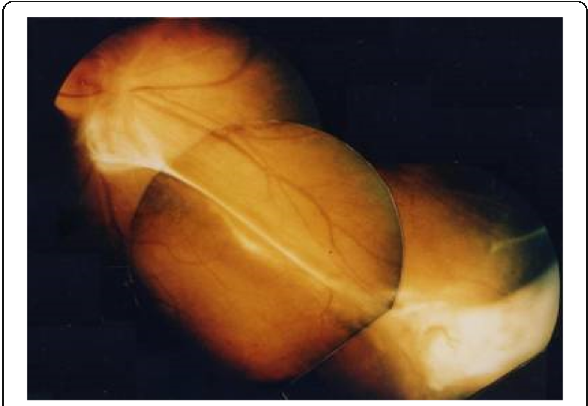
Fig. 2 Ocular toxocariasis with peripheral granuloma and vitreoretinal traction (Cortez et al.